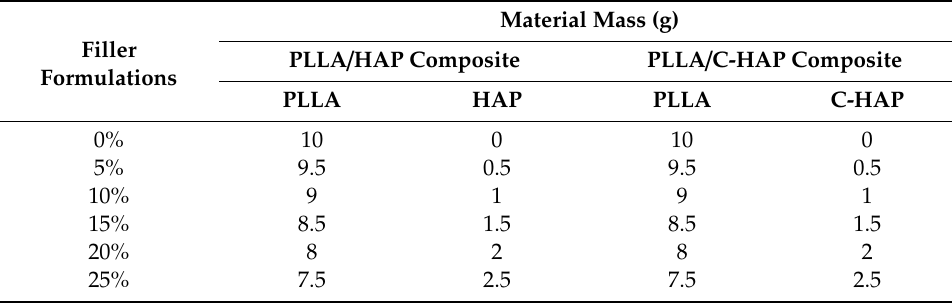
Table 1. Material compositions of the composite